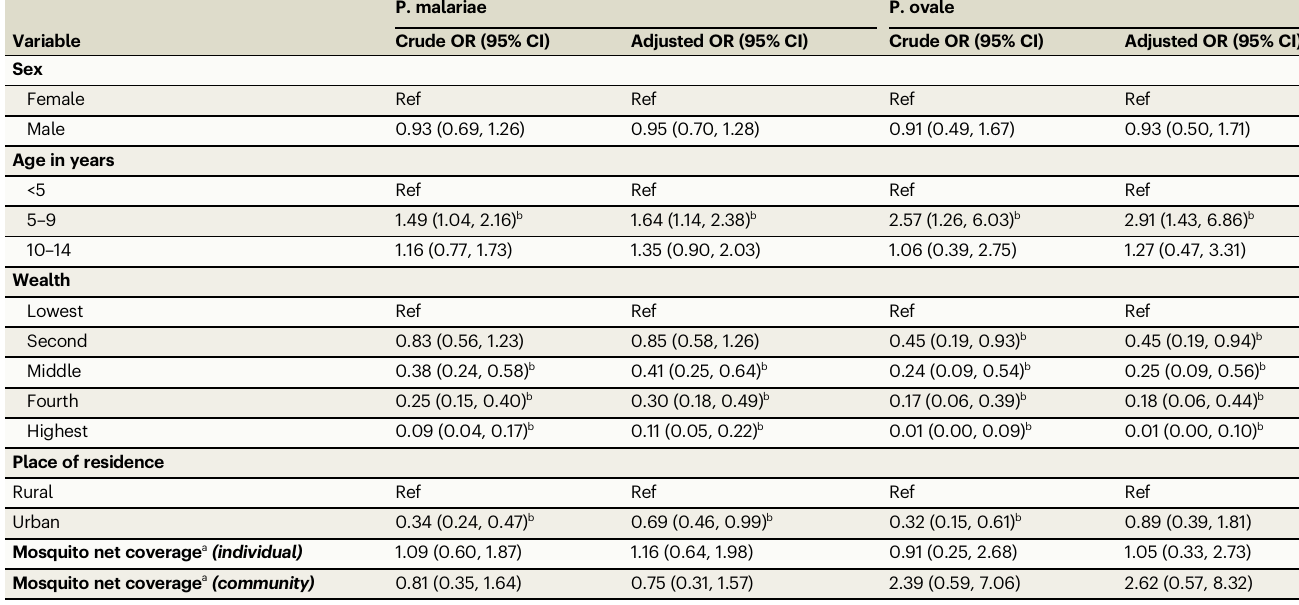
distribution of all identi fi ed active infections by Plasmodium species and children ’ s ages. Table 2 displays crude and adjusted estimates for odds of infection with any P. malariae or P. ovale parasites with adjusted estimates controlling for individual and community risk fac- tors. For adjusted estimates, no association was observed between